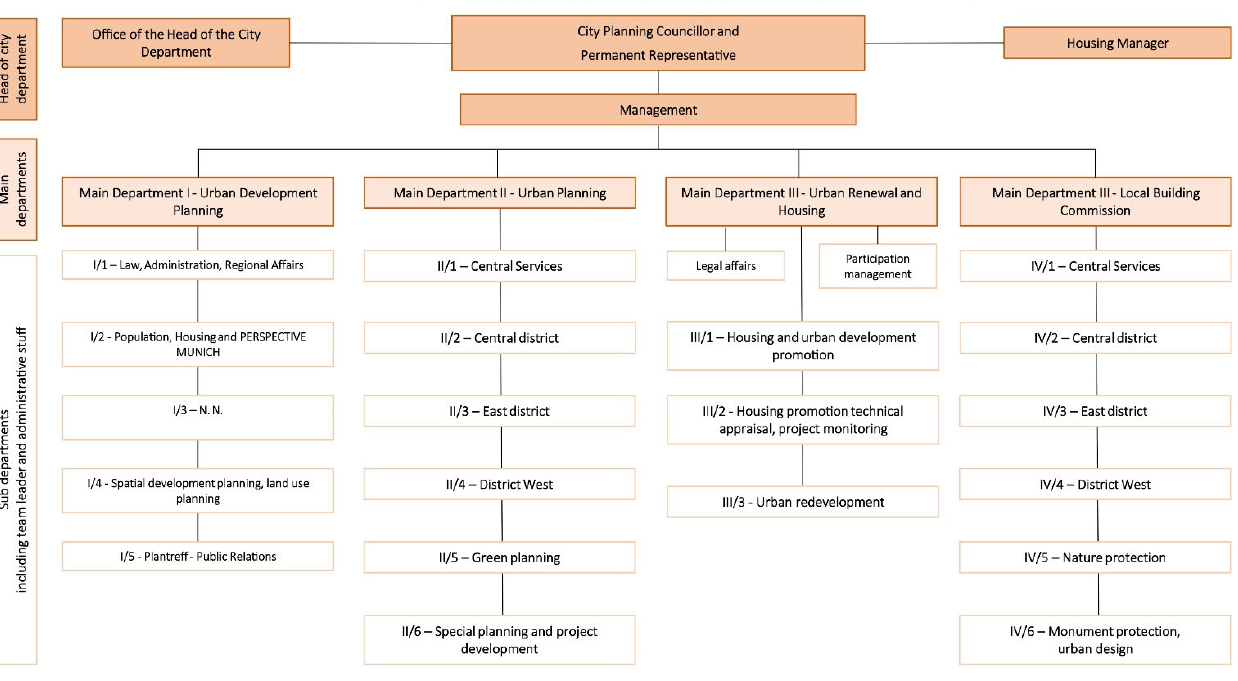
Figure A1. The management structure and the hierarchical levels in the City Department for Urban Planning and Building Regulations, adapted from